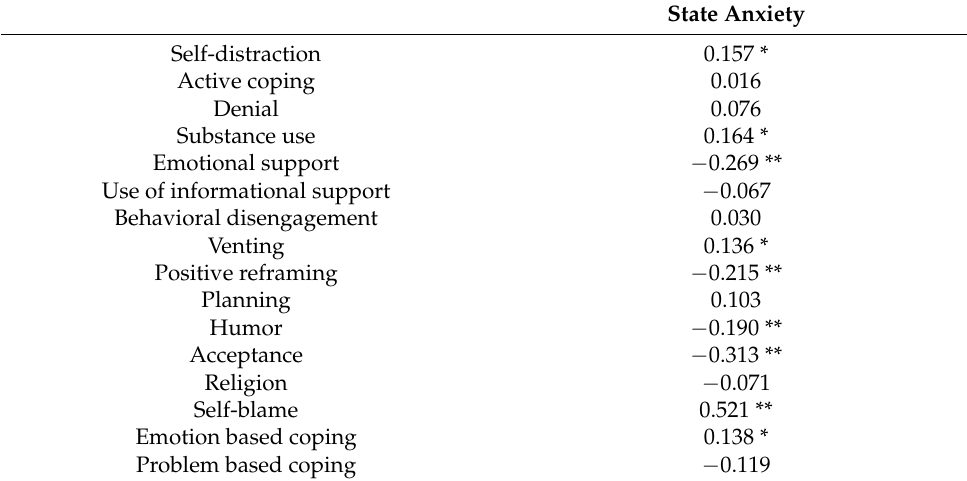
Table 5. Correlations between coping strategies and anxiety of infertile women.